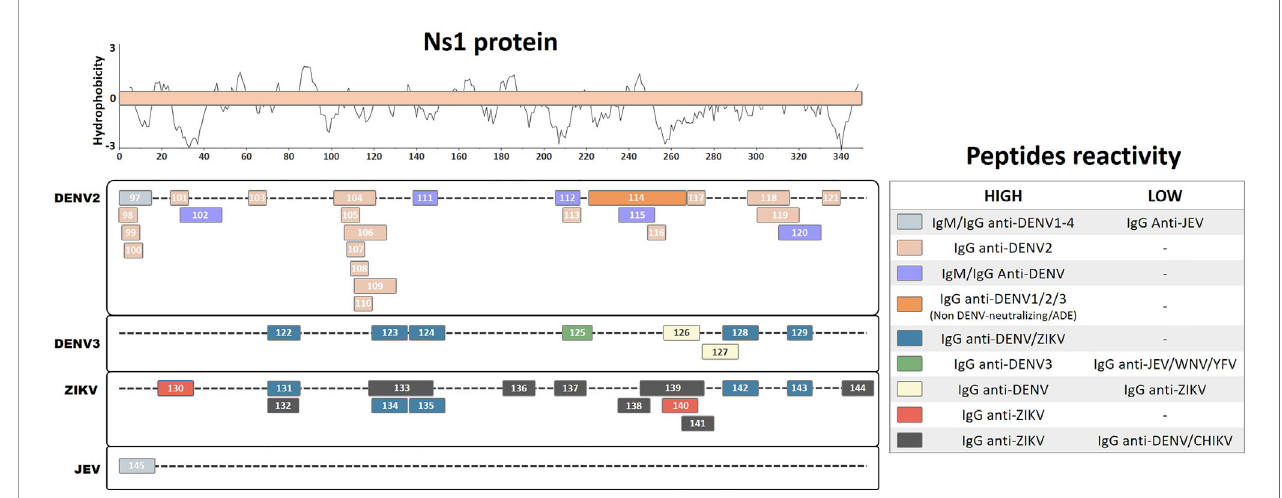
FIGURE 4 | Linear representation of the NS1 protein. Linear peptides are labeled by numbers and the antibody reactivity indicated by colors. The hydrophobicity prediction pro fi le was determined using the amino acid sequence of the ZIKV (Genbank YP_002790881) with the Kyte & Doolittle hydropathy score scale (J. Mol. Biol.